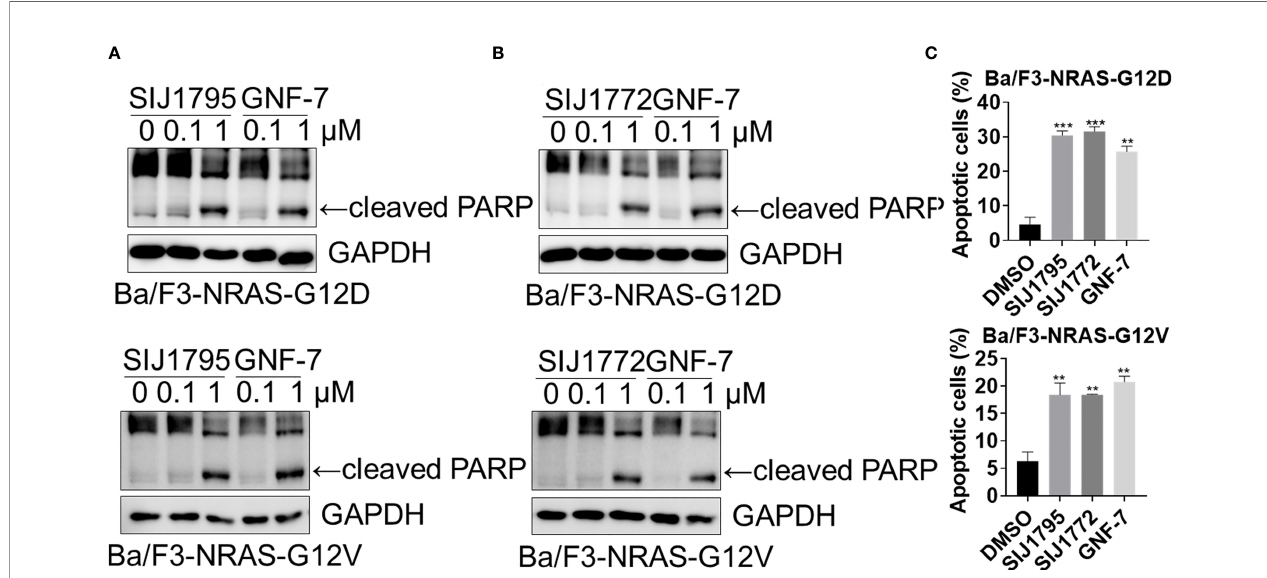
FIGURE 3 | (A, B) The effects of SIJ1795 and SIJ1772 on apoptosis induction in Ba/F3 cells transformed with mtRAS (NRAS-G12D and NRAS-G12V). Cells were treated with 0.1 and 1 m M of SIJ1795, SIJ1772, and GNF-7 for 24 h Western blot analysis was conducted to evaluate the cleaved PARP and level. GAPDH was used as a loading control. (C) Apoptotic cell population (annexin V-positive) was determined by fl ow cytometry analysis (n = 3). Cells were treated with 1 m M of indicated compounds for 24 h. Statistical signi fi cance was calculated by a one-way ANOVA analysis (**p < 0.01, ***p <